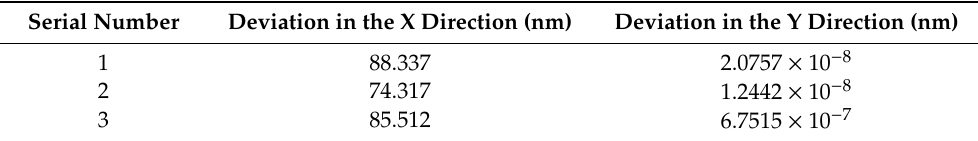
Table 3. Center point alignment error.